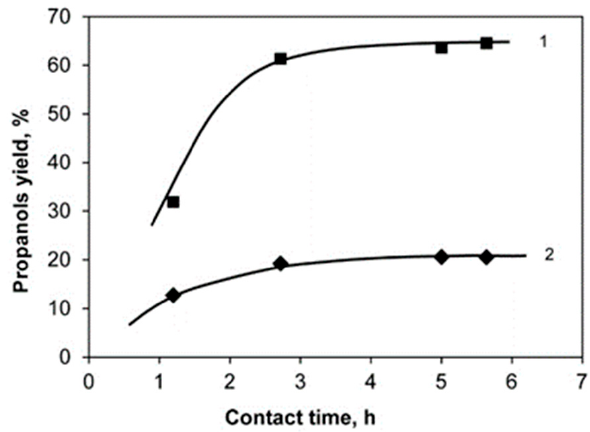
Figure 6. The dependence of the yield of 1-Pr (1) and 2-Pr (2) on the contact time. Conditions: the catalyst 20%Ni/18%WO 3 -ZrO 2 , 30% glycerol solution, T = 260 °C, P H2 = 2.55 MPa.